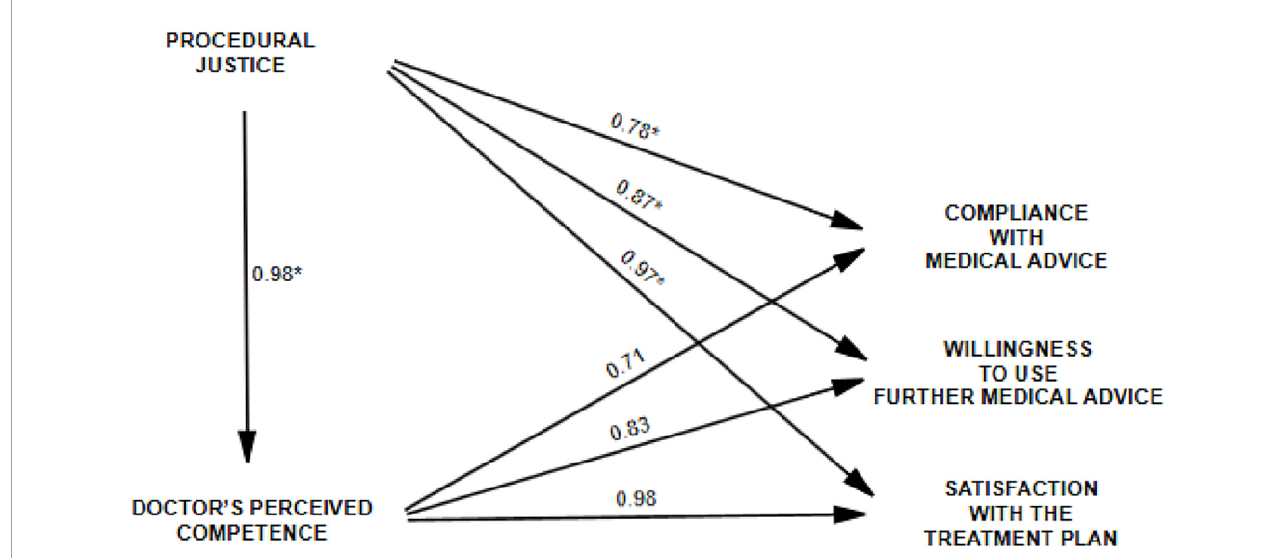
FIGURE1 Results of path analysis (standard β path coefficients) for the models of the hypothesized relationships. *Mean value from al the models built and